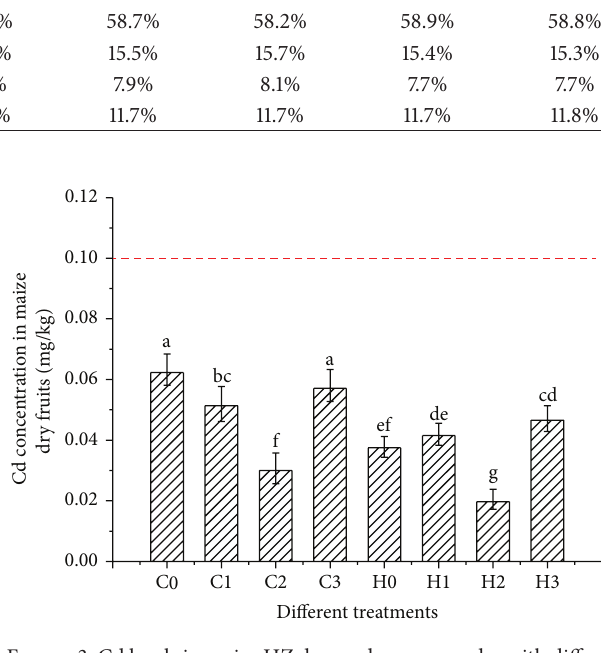
Figure 3: Cd levels in maize HZ dry seeds grown under with differ- ent NTA treatments. The broken line is the maximum permissible concentration of Cd in Chinese coarse cereals including the maize seeds (0.1mg/kg, dry weight) (GB2762-2005)